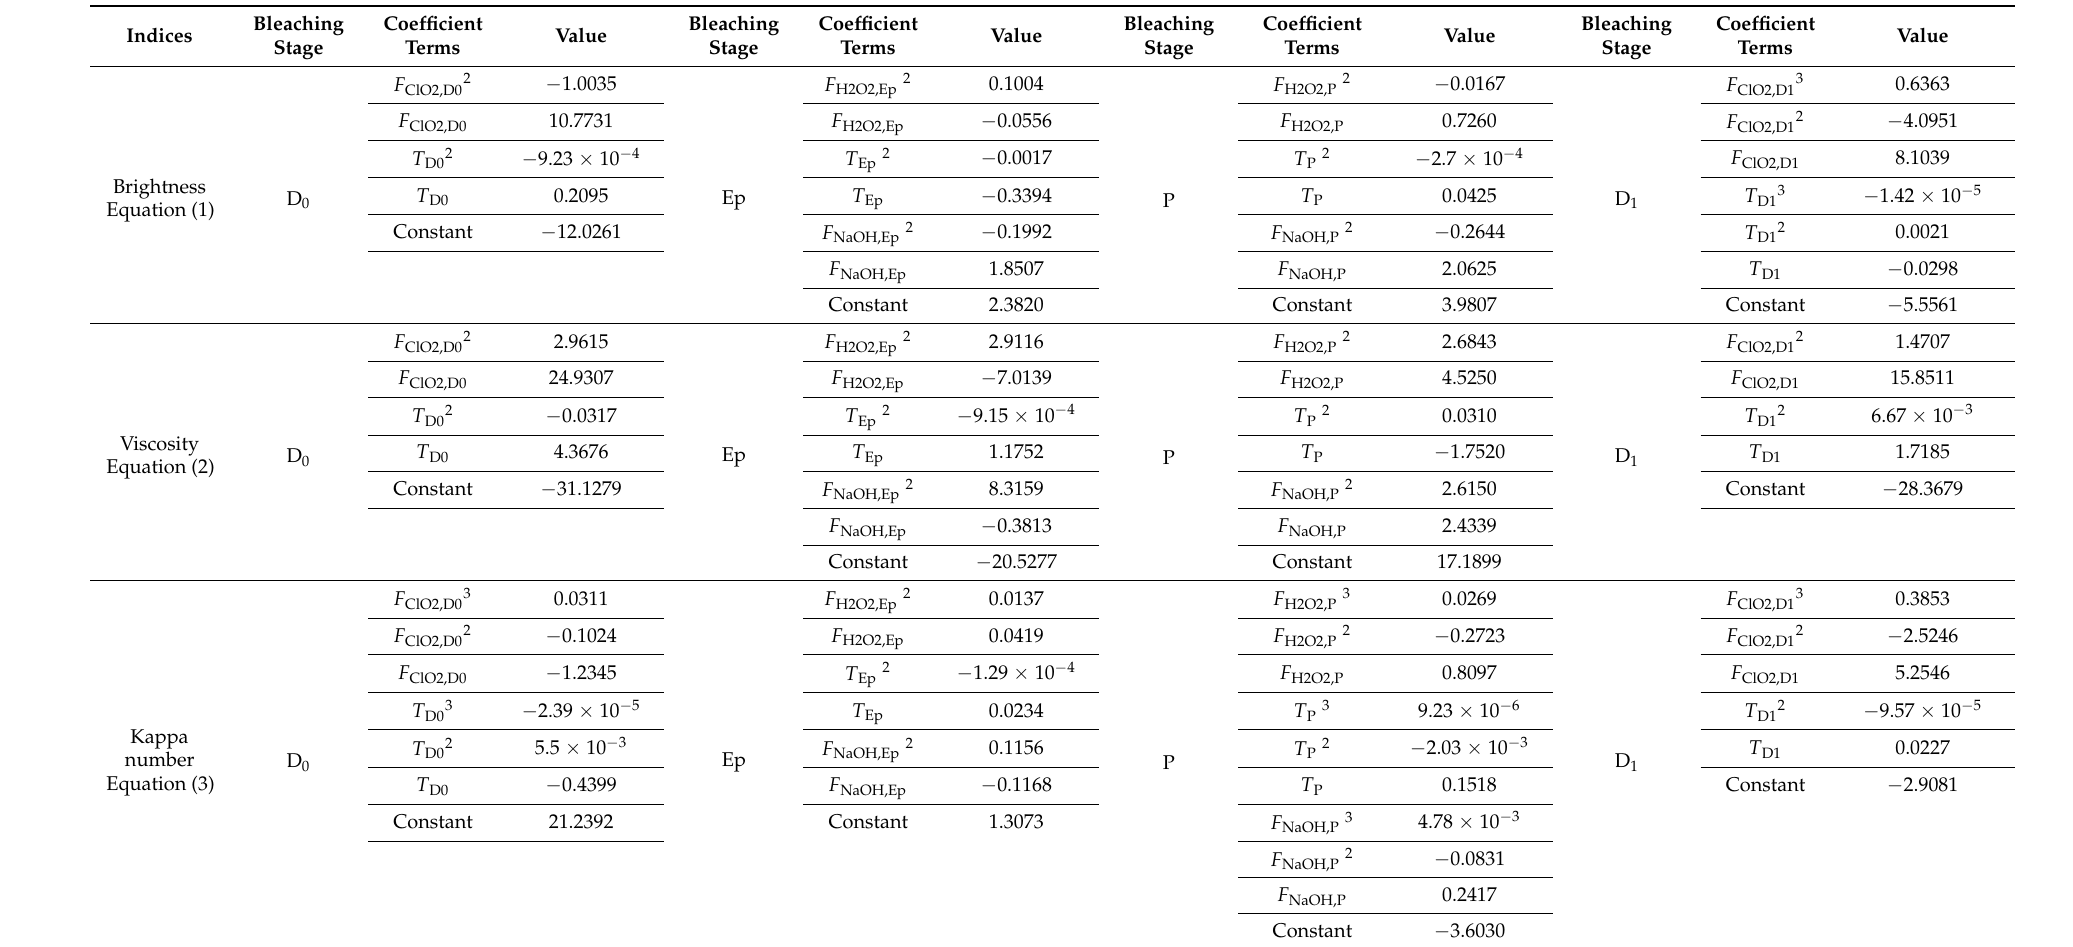
Table 3. Calculating equation of pulp quality after